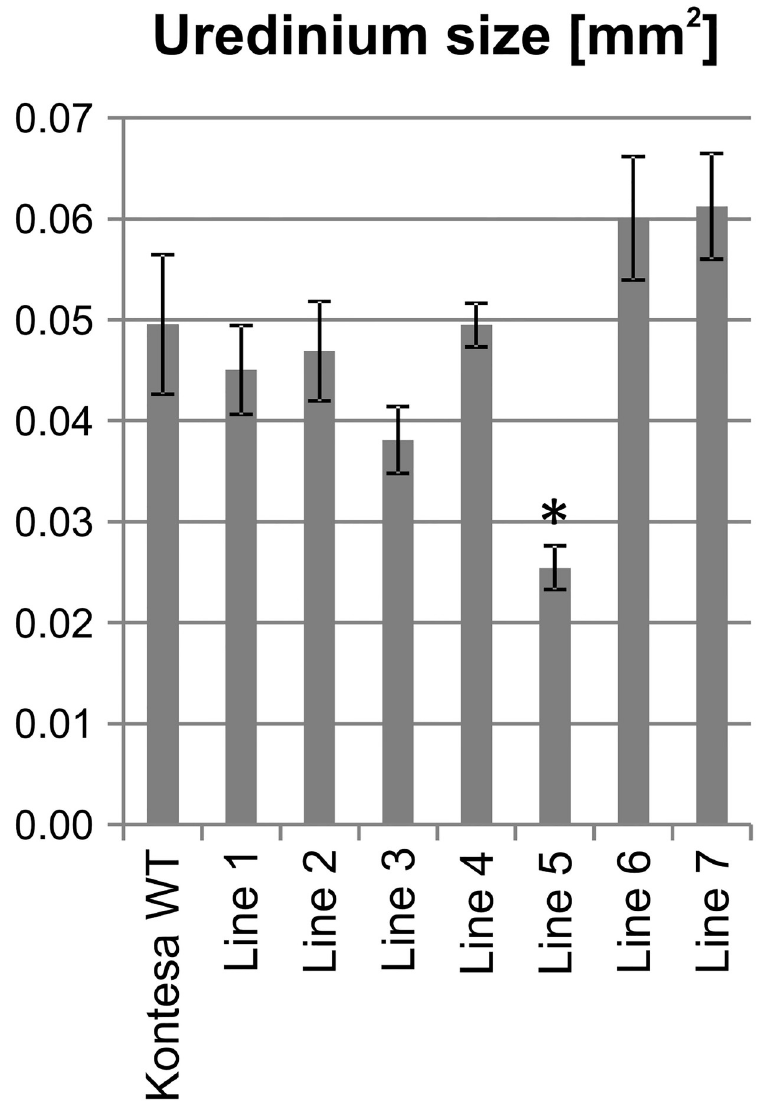
Fig 6. The average uredinia size developed on flag leaves of non-transgenic Kontesa and seven transgenic lines overexpressing TaWAK6 gene 16 days post inoculation with P . triticina . Data represent mean values with standard errors of the mean; asterisk indicates p < 0.05 using the ANOVA test followed by LSD post-hoc test (STATISTICA 10, StatSoft).